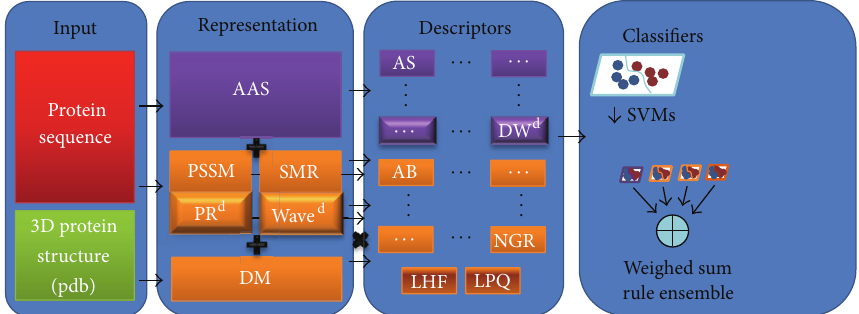
Figure 1: Schema of the proposed